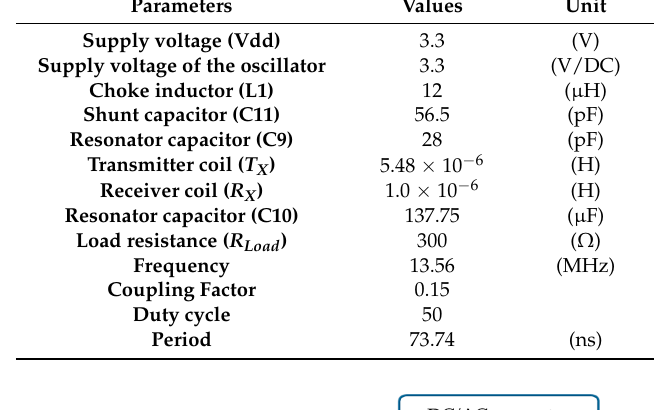
Figure 14. Eclectic design of the proposed near-field RIC WPT system. Table 8. System parameters values. Table 8. System parameters values.